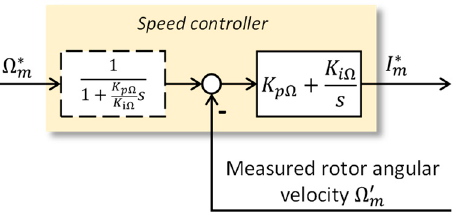
Figure 3. I-P speed controller obtained by filtering the speed setpoint (continuous-time domain).